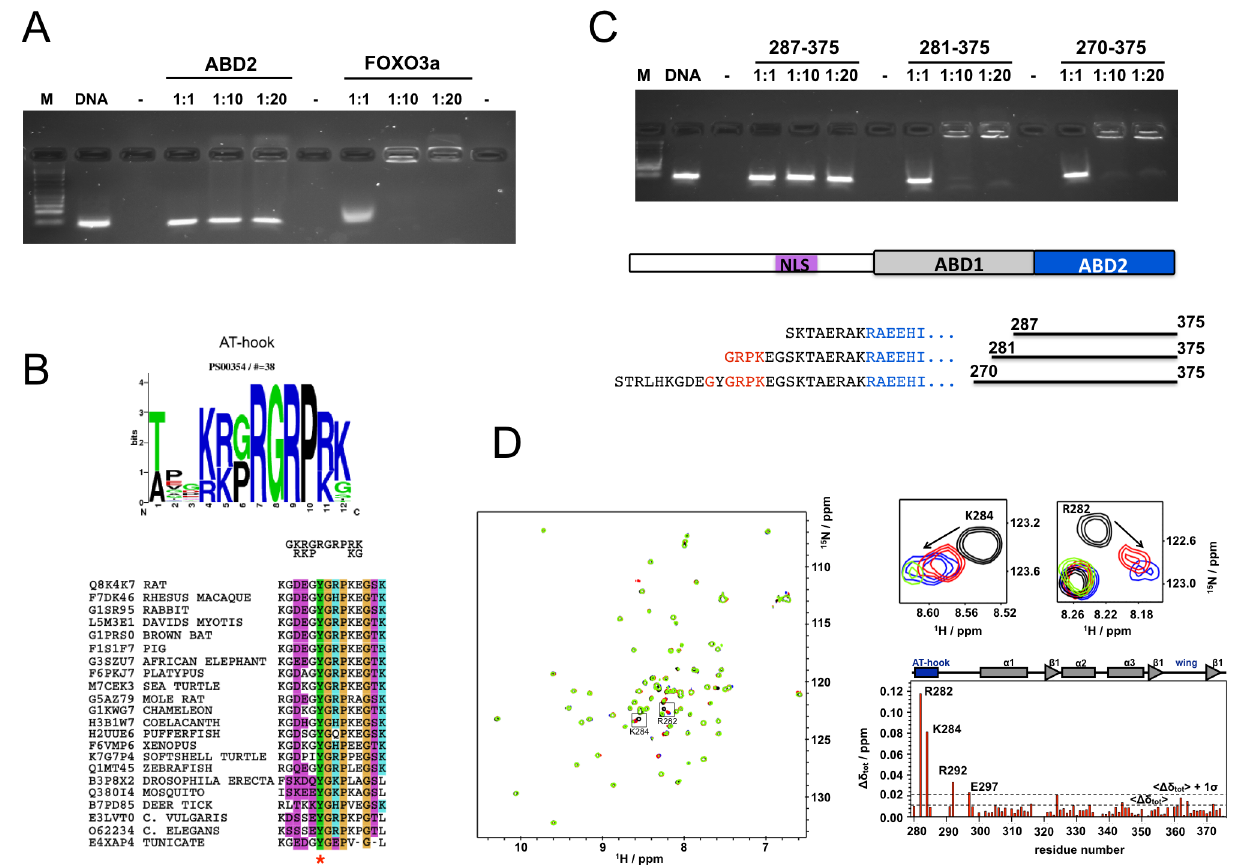
Fig 2. DNA binding of Ms1. A: EMSA experiment of ABD2 and FOXO3a as a positive control with a random 18mer library (2 μ M). B: consensus motif of the AT-hook shown as web logo [40] (based on PROSITE entry PDOC00306) and in short form on top of a sequence alignment of the AT-hook motif in selected Ms1 sequences. Colours are: purple — hydrophilic; green — hydrophobic; orange — proline and glycine; blue — positive charge. Phosphorylation sites identified experimentally are indicated by a star [15,41]. C: EMSA of N-terminally extended ABD2 constructs with the same 18mer random library used in A. The overall Ms1 topology is shown together with the detail of the N-terminus of the various constructs. Residues at the N-terminus of ABD2 are shown in blue and those of the AT-hook in red. D: NMR analysis of the interaction of Ms1 270 – 375 with AT-rich DNA ds oligonucleotides. Spectra of Ms1 270 – 375 without (black) and with (1:0.5 red; 1:1 blue; 1:2 green) of the oligonucleotide are shown superimposed together with a detailed view for two selected residues from the N- terminus. The chemical shift perturbations are summarised in a plot against the amino acid sequence that is annotated with the functional and structural properties of the 270 – 375